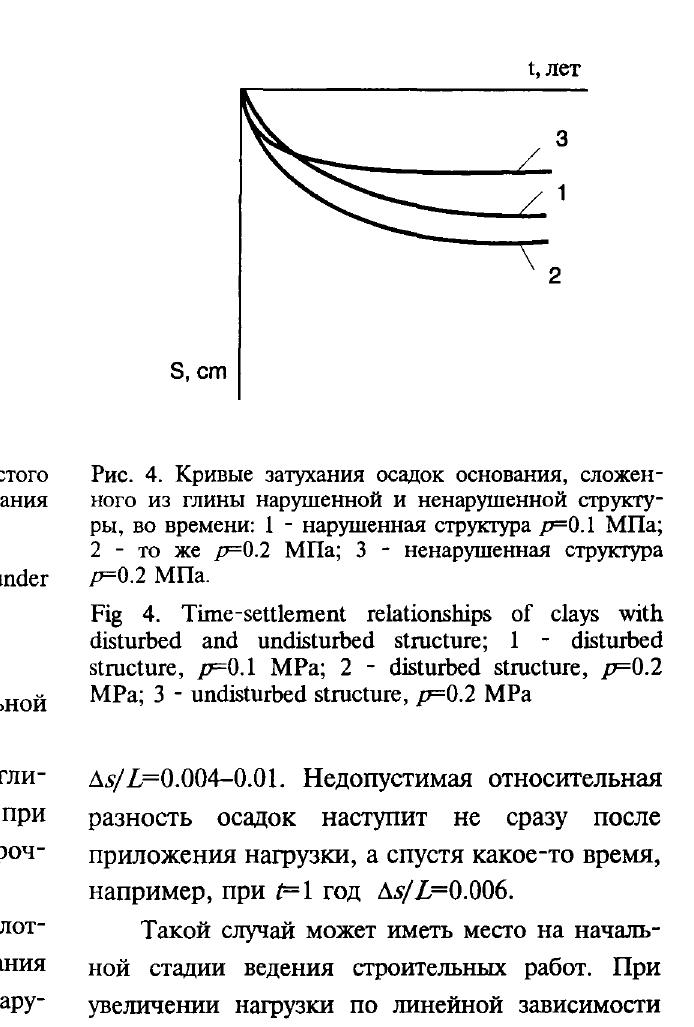
Fig 3. Compression zone of undisturbed clay under stress a z < a s Fig 4. Time-settlement relationships of clays with disturbed and undisturbed structure; 1 - disturbed structure, p==O.l MPa; 2 - disturbed structure,